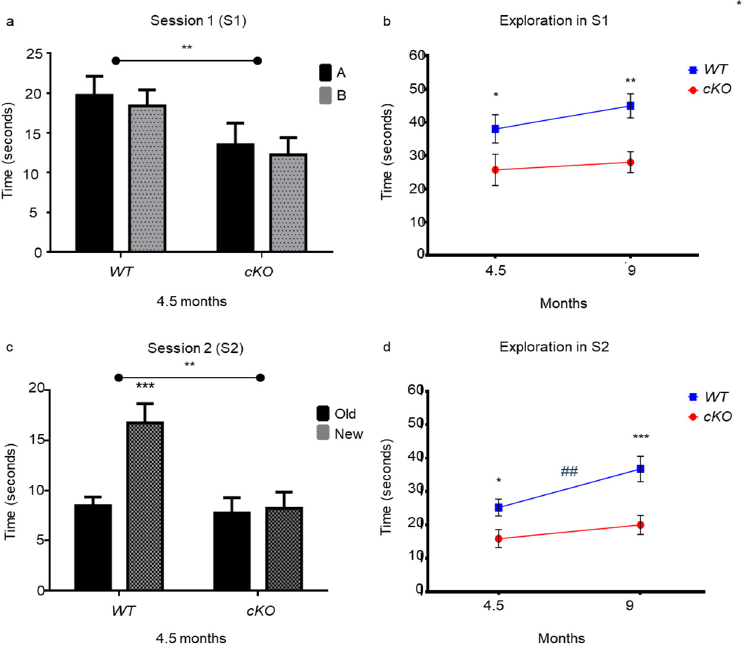
Figure 4. Vision and visual memory assessment of WT ( n = 20) and cKO ( n = 18) mice using object recognition test. ( a ) Session 1 (S1): exploration time for the same set of objects at position A and position B. ( b ) Total exploration time in S1 at 4.5 and 9 months of age. ( c ) Session 2 (S2): exploration time of an old object used in S1 and a novel object, which were positioned randomly in the apparatus. ( d ) Total exploration time in S2, in seconds, at 4.5 and 9 months of age. Statistical significance is shown as: * p ≤ 0.05, ** p ≤ 0.01, *** p ≤ 0.001. ## p ≤